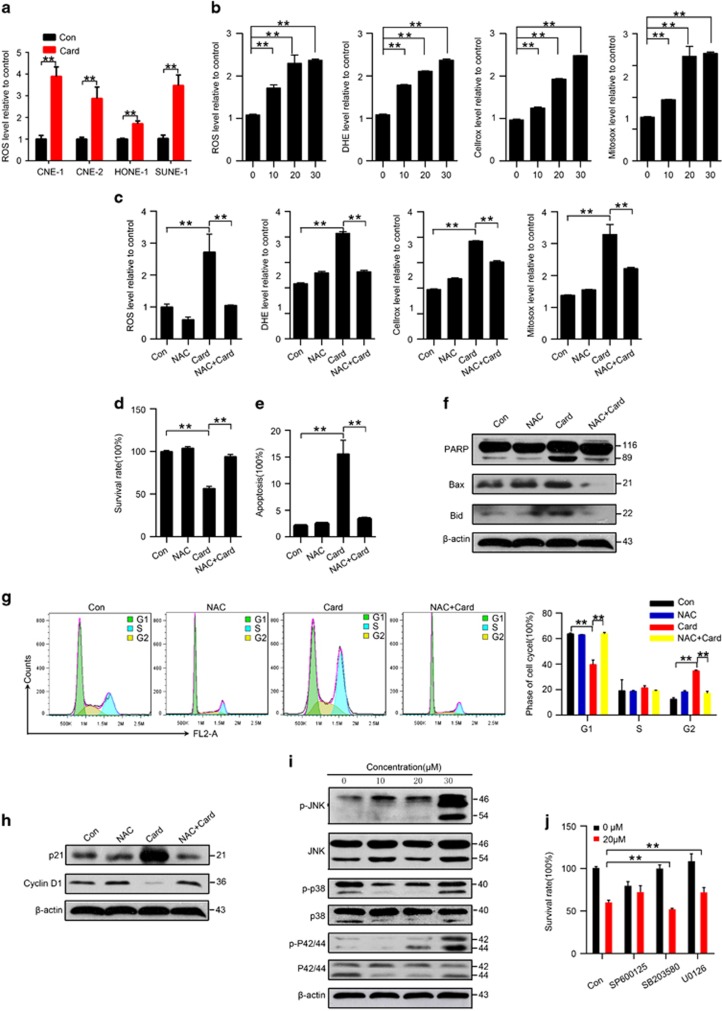
Cardamonin inhibited CNE-2 cells in a ROS- and JNK-dependent manner. (a) NPC cells were treated with cardamonin for 24 h and intracellular ROS were evaluated by flow cytometry using DCFH-DA. **P<0.01, n=3. (b) CNE-2 cells were treated with cardamonin for 24 h and intracellular ROS were evaluated by flow cytometry using DCFH-DA, MitoSOX, CellRos and DHE. **P<0.01, n=3. CNE-2 cells were treated with 20 μM cardamonin with or without 10 mM NAC, then intracellular ROS (c), cell viability (d), apoptosis (e), expression of Bid, Bax and PARP (f), cell cycle (g) and expression of Cyclin D1 and p21 (h) were measured. (i) Expression of p-JNK, JNK, p-p38 MAPK, p38 MAPK, p-p42/44 MAPK and p42/44 MAPK were evaluated by western blotting after treatment with indicated concentration of cardamonin for 24 h. (j) CNE-2 cells were treated with JNK inhibitor (SP600125), p38 inhibitor (SB203580), p42/44 inhibitor (U0126) with or without cardamonin and cellular viability were measured with a CCK-8 assay